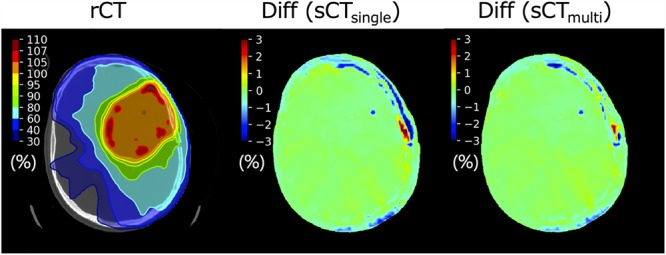
Comparison of the dose difference maps for VMAT plans between sCTsingle and sCTmulti (Patient #5).